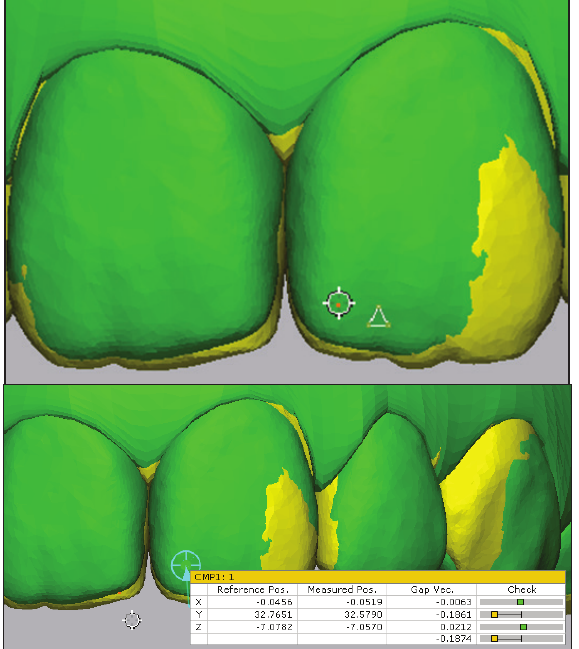
Figure 4. Single point comparison. Selection of a comparison point on superimposed models (4a) will allow generation of 3D measurements of the displacement of that point from the reference model to the measured model (4b).